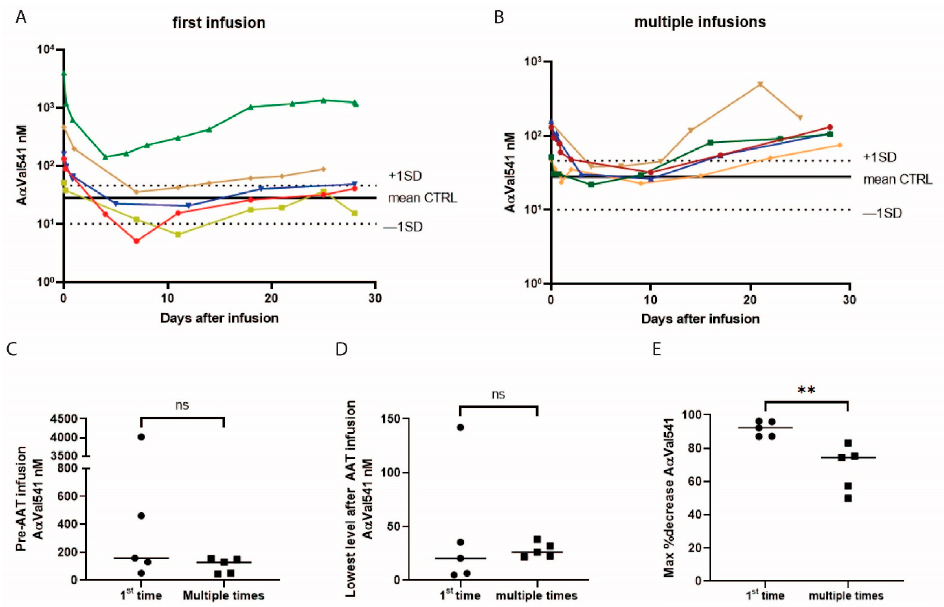
Figure 4. The A α Val541 levels decrease to the average range of healthy controls after a single dose of AAT. ( A ) The course of the A α Val541 plasma level in 5 patients who received AAT augmentation therapy for the first time are shown, as well the average A α Val541 of the 20 healthy controls (black horizontal line). ( B ) The course of the A α Val541 level in 5 patients who already received AAT augmentation therapy in the months before. ( C ) The A α Val541 plasma levels before the single dose of 240 mg/kg AAT of patients who received AAT infusion for the first time and patients who received AAT infusion before. ( D ) The lowest A α Val541 value after 240 mg/kg AAT in patients who received AAT infusion for the first time and patients who received AAT infusion before. ( E ) The maximum percentage of A α Val541 decrease with respect to the A α Val541 level prior to the monthly dose of AAT infusion both groups. ns, non-significant difference, Mann–Whitney U test, **; significant difference p = 0.0079, Mann–Whitney U test.